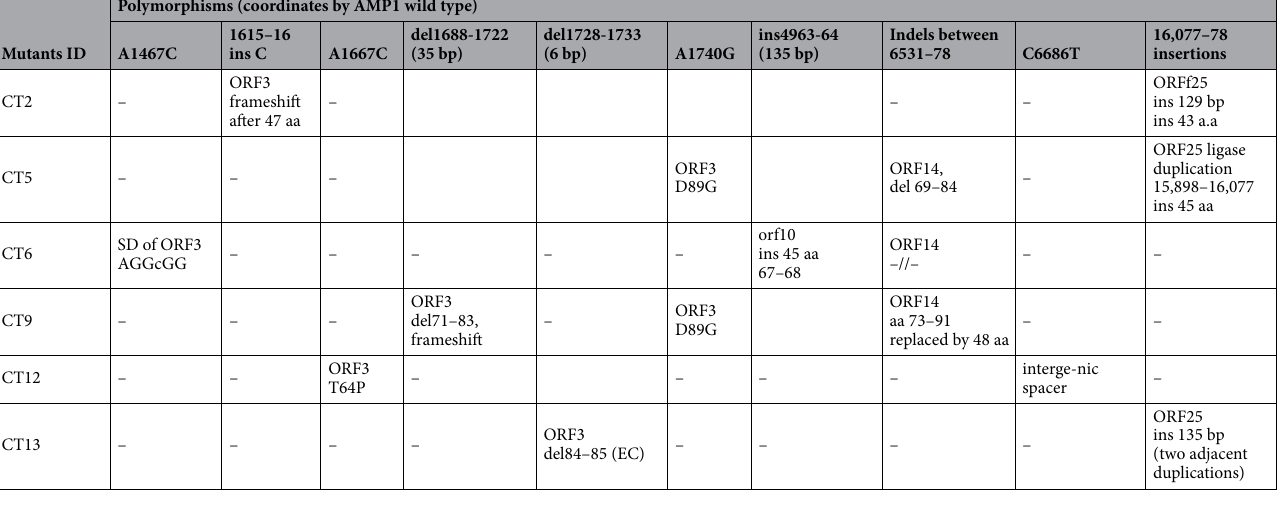
Table 1. Polymorphisms in the genomic sequences of the CT mutants putatively involved in cold-tolerant phenotype determination. The loci affected by these polymorphisms and types of alterations are given in the cells. Designations: SD Shine-Dalgarno ribosome-binding site, del deletion, ins insertion, indels between multiple nucleotide deletions and insertions in the indicated sequence region, “–” the polymorphism is not present in the corresponding